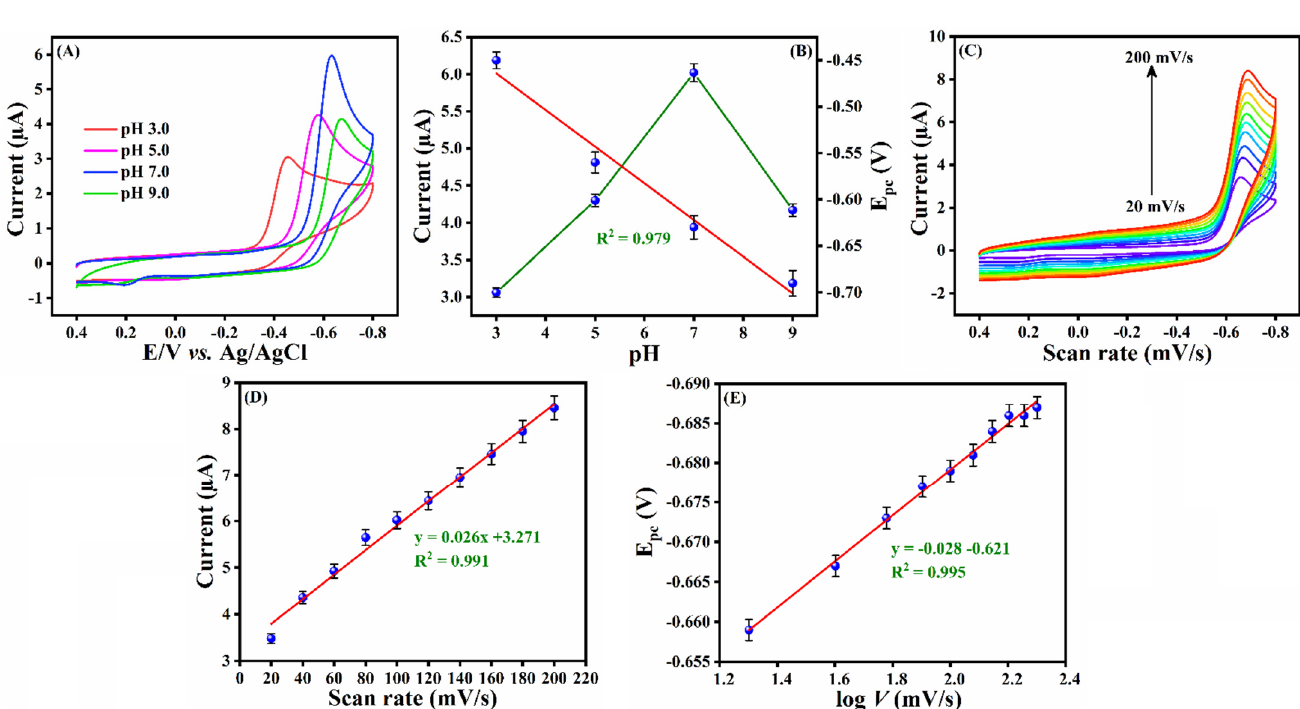
Figure 6. Data recorded in 50 μ M SCZ in 0.05 M PBS at ZTO/TO MPs/GCE ( A ) at pH values of 3.0, 5.0, 7.0, and 9.0 at 50 mV/s; ( B ) peak current plotted as a function of pH (green) and the peak potential as a function of pH (red); ( C ) CVs at different sweep rates of 20–200 mV/s; ( D ) peak current plotted as a function of scan rate; and ( E ) peak potential as a function of the logarithm of scan rate ( E pc vs. log V ).